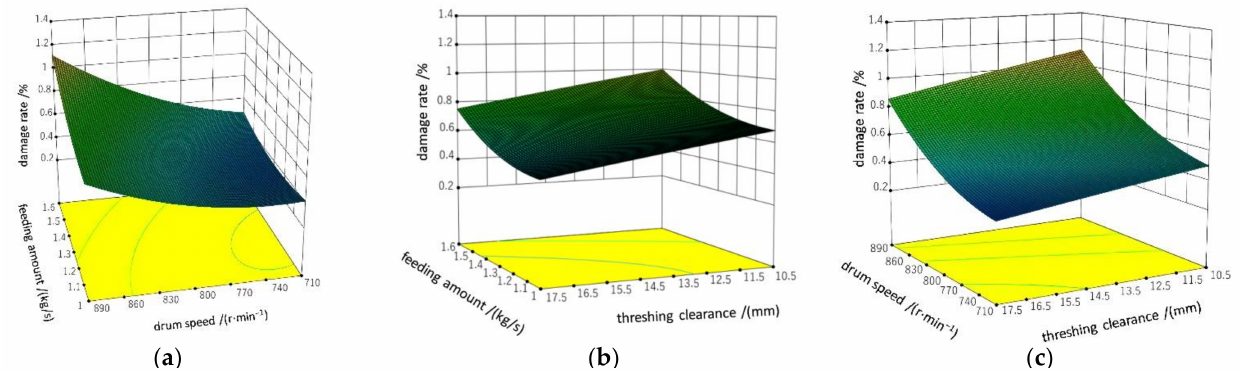
Figure 13. Influence of drum speed, feeding amount, and threshing clearance on damage rate. ( a ) the picture shows the influence of drum speed and feeding amount on damage rate; ( b ) the picture shows the effect of threshing clearance and feeding amount on damage rate; ( c ) the picture shows the effect of threshing clearance and drum speed on damage